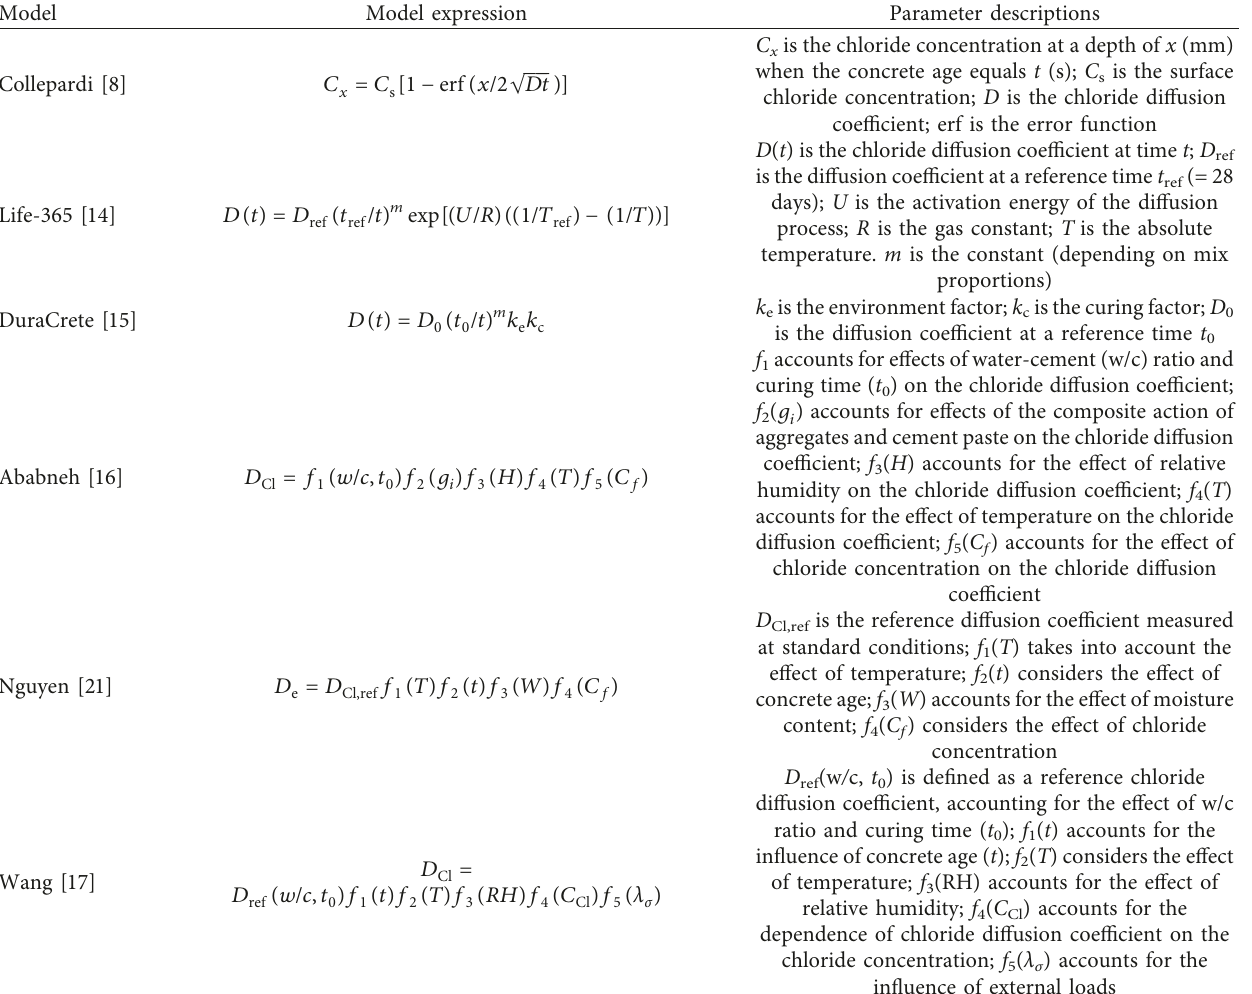
Table 2: Chloride diffusion models from different reports.